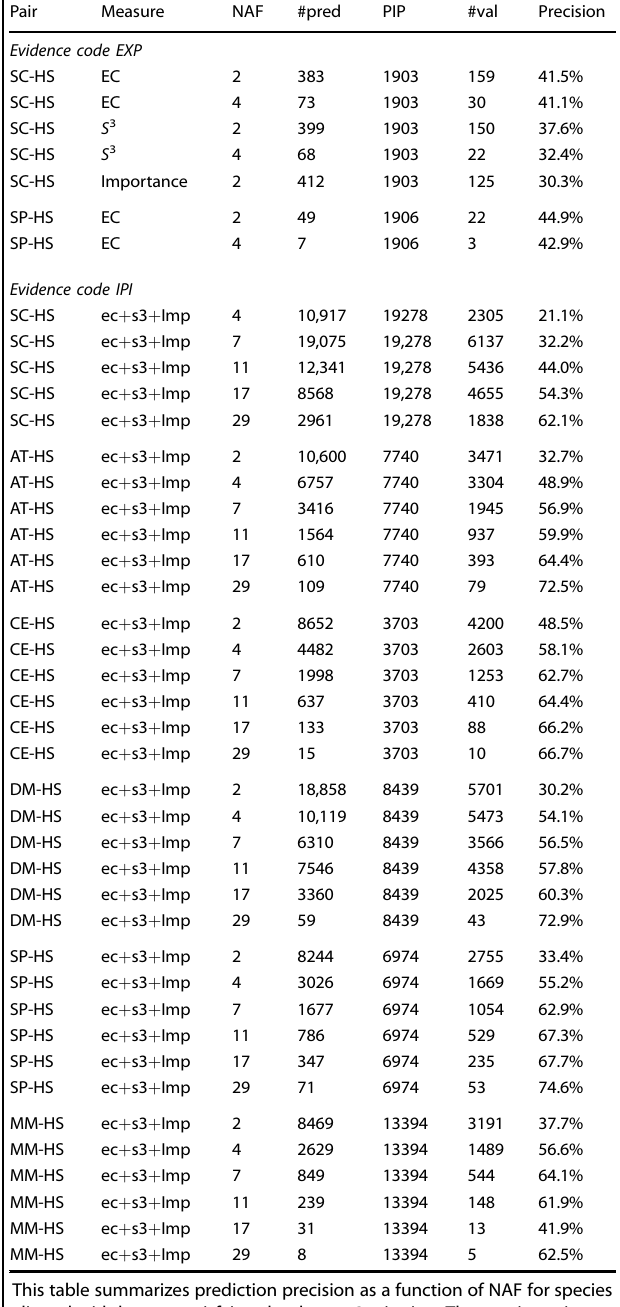
Table 2. Prediction precision by evidence code and NAF threshold with H. sapiens as the target.